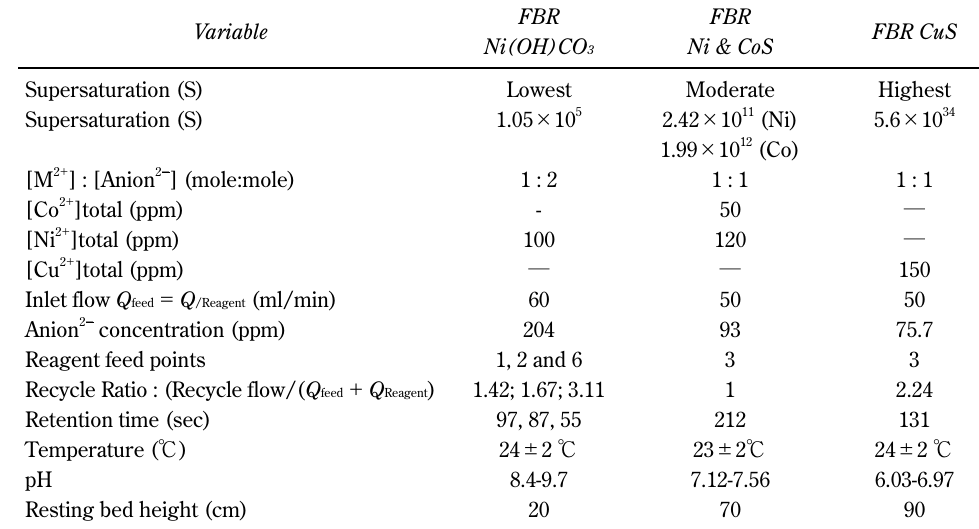
Table 1 Experimental conditions for the three case studies Variable